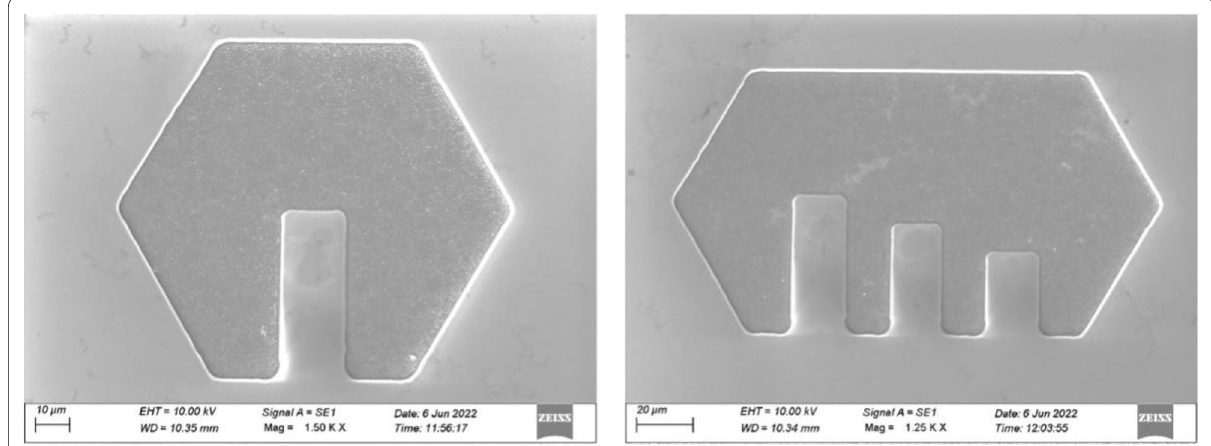
Fig. 9 SEM images of the cantilever beams fabricated on Si{111} in NaOH